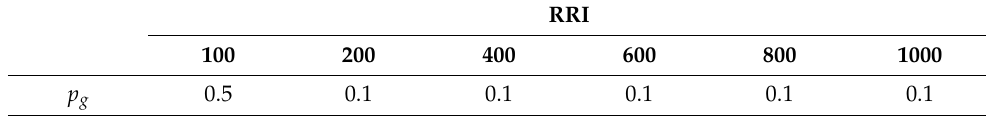
Table 5. Generation pattern 2.